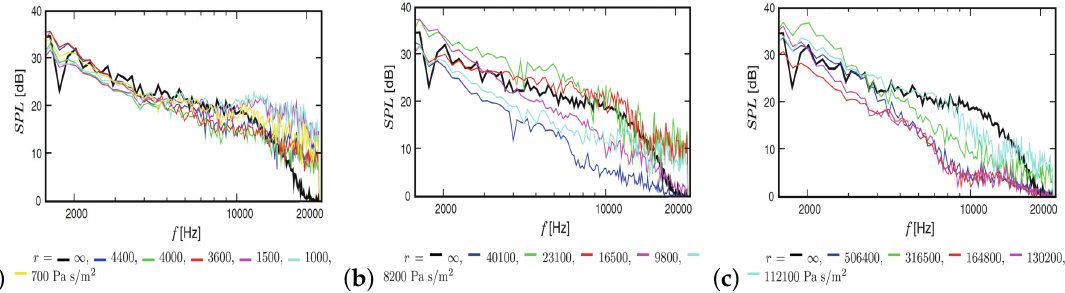
Figure 16. Sound pressure level at α = 0 ◦ and u ∞ = 50 m/s, reprinted from [158] with permission from